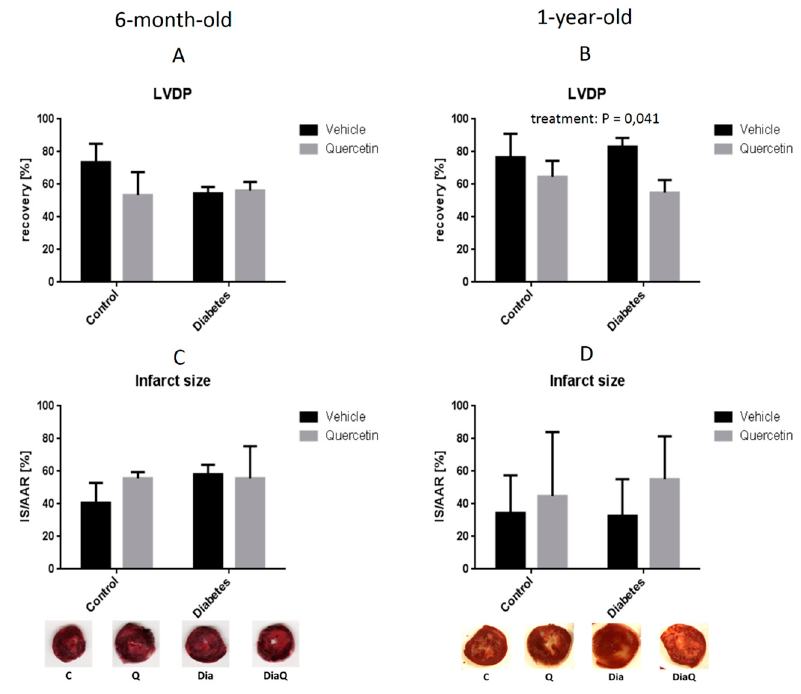
Figure 5. Post-ischemic recovery of left ventricle developed pressure (LVDP, systolic minus diastolic pressure) of isolated hearts from ZDF rats treated with quercetin measured in 40th minute of post-ischemic reperfusion after 30-min global ischemia in younger ( A ) and older ( B ) rats. Infarct size related to area at risk (whole left ventricle in case of global ischemia) measured by 2,3,5-triphenyltetrazolium (TTC) staining after 2-hour reperfusion of isolated hearts from younger ( C ) and older ( D ) ZDF rats. Results are expressed as mean ± SEM. Significant differences were evaluated by two-way ANOVA for main factors diabetes and quercetin treatment.